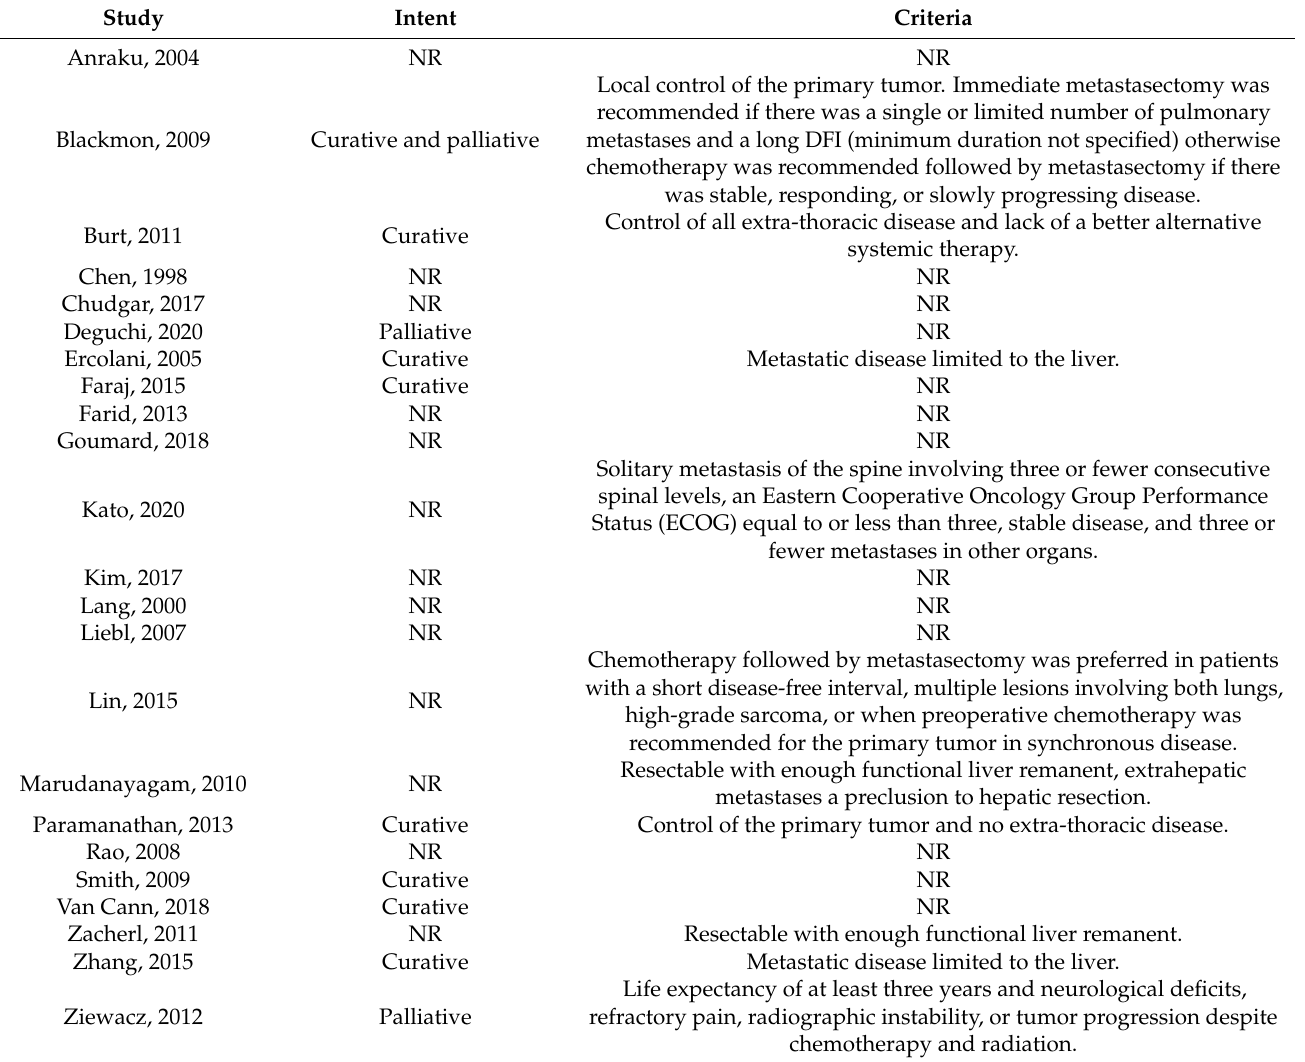
Table 4. Intent and criteria for metastasectomy reported by